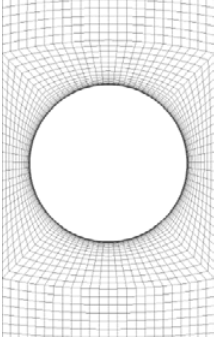
Figure 6. Grid refinement of the tube wall.